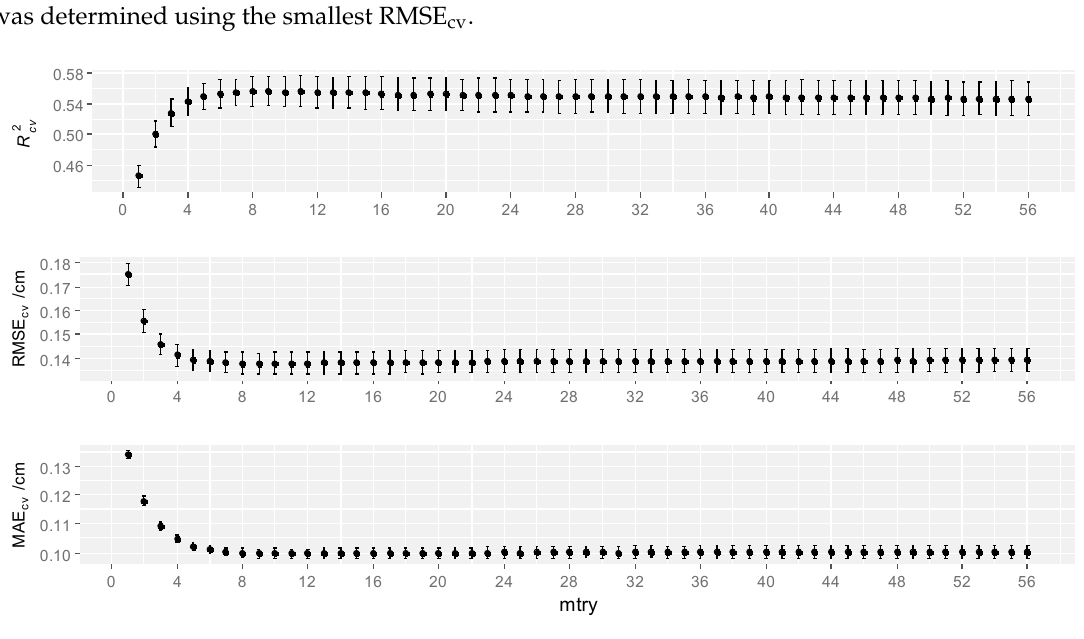
Figure 1. Tuning random forest (RF)—the effect of mtry on RF model performance. The tenfold cross-validation was used for model validating. The error bar is standard deviation. The parameter, mtry, is the number of predictive variables randomly sampled as candidates at each split and controls the correlations between trees.